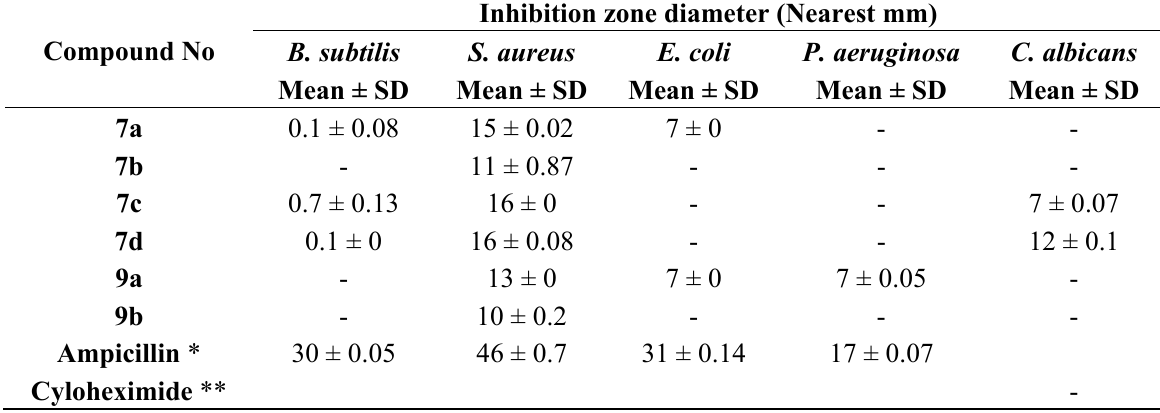
Table 3. Diameter of the zones of inhibition of the tested compounds that showed weak to strong antimicrobial against microorganisms. Inhibition zone diameter (Nearest mm) Compound No